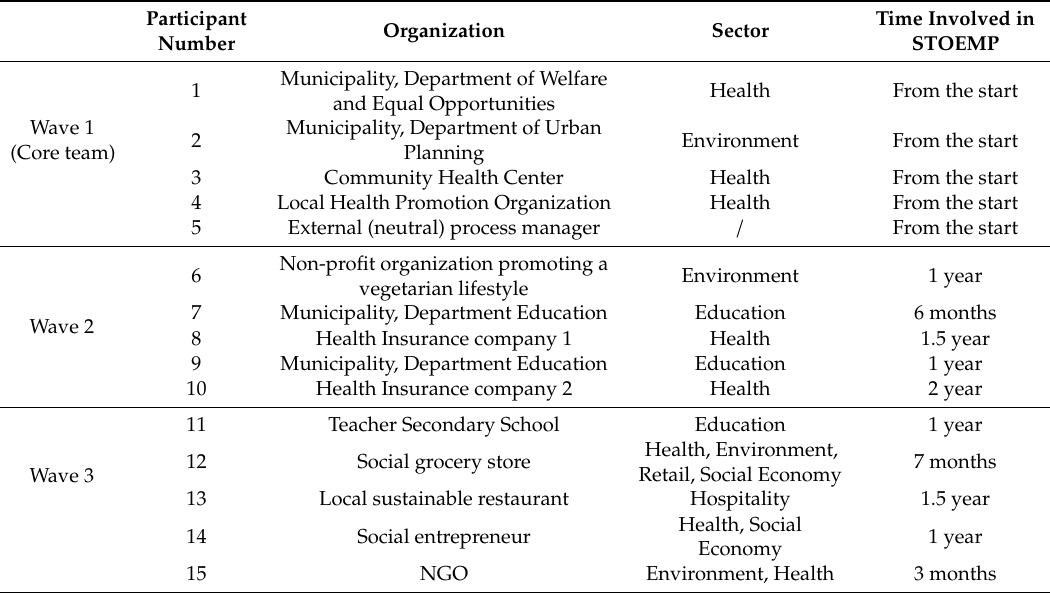
Table 2. Characteristics of the study participants ( n =